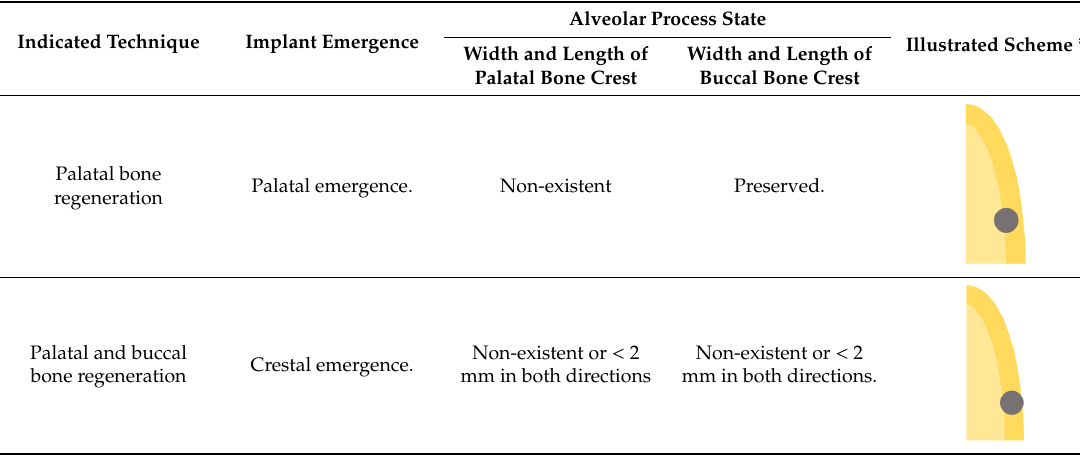
Table 2. Indication criteria for bone regeneration or soft tissue enhancement techniques.